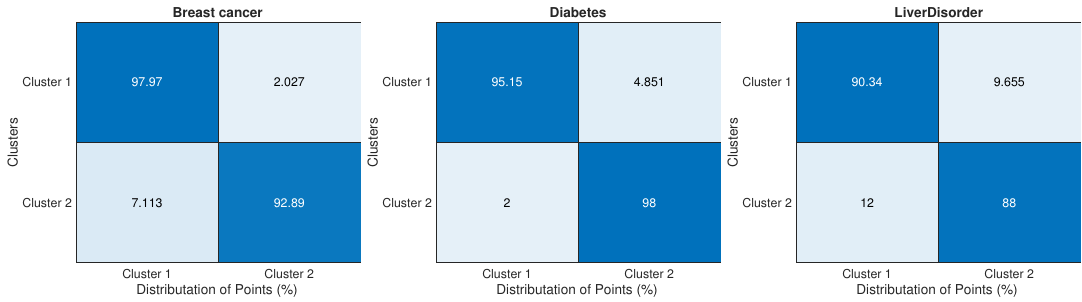
Figure 9. Cluster analysis for 3 datasets.